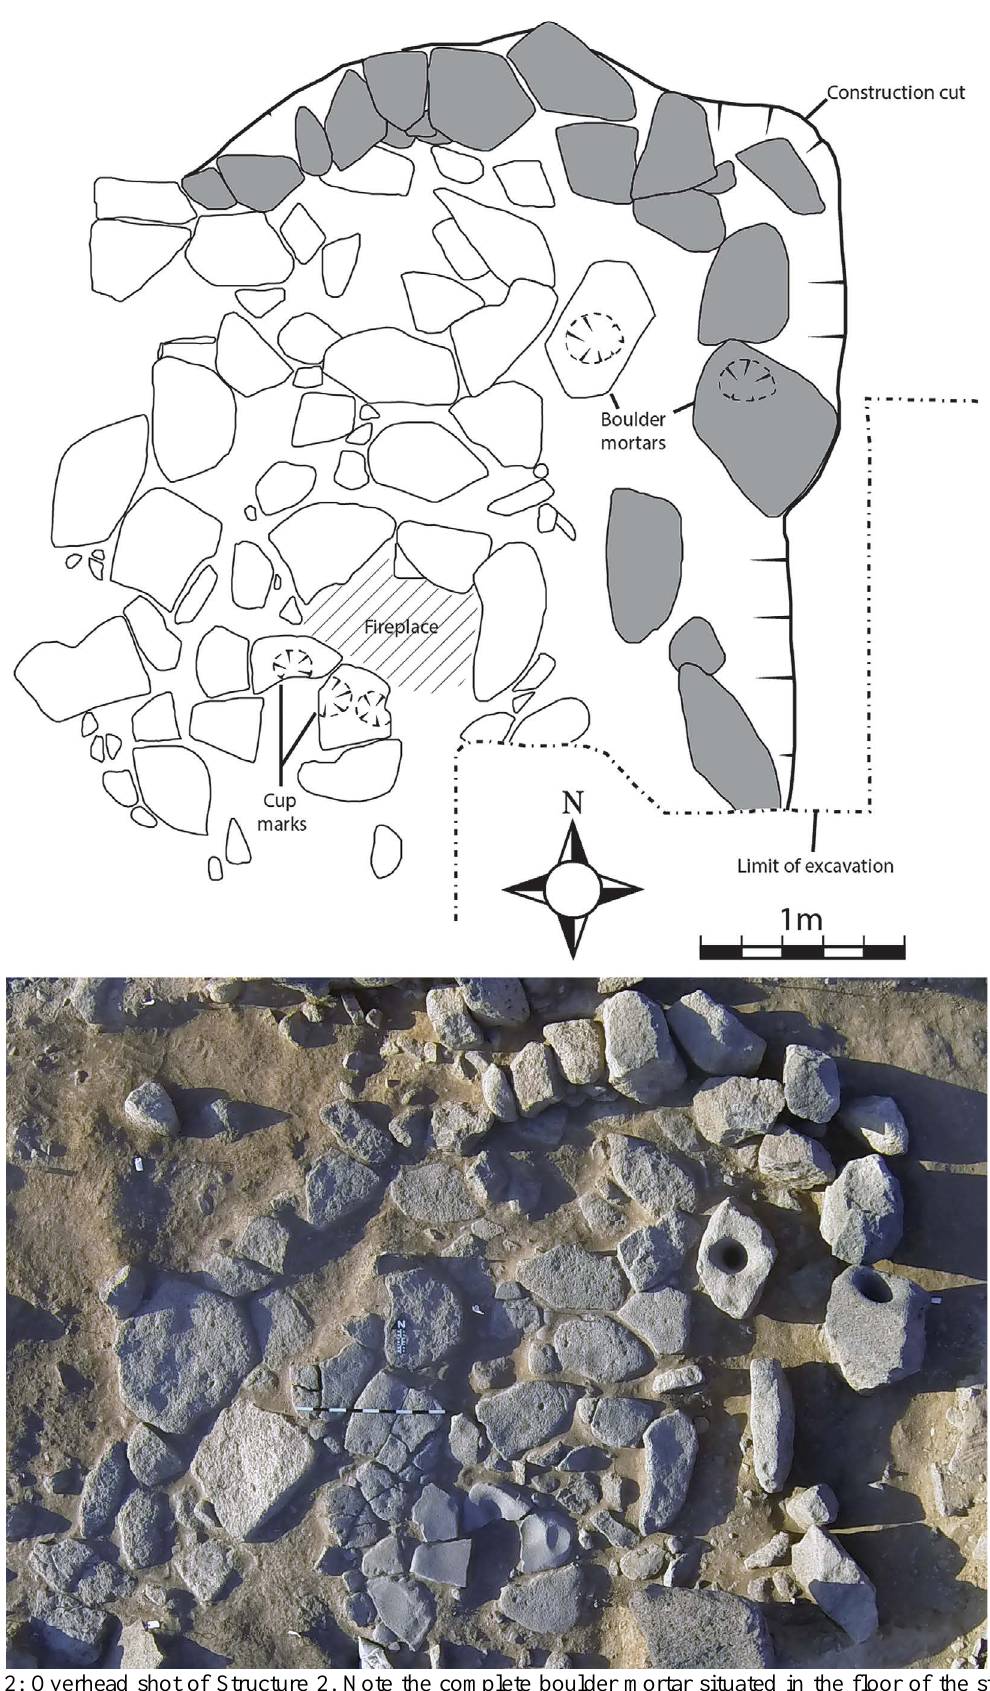
Figure 2: Overhead shot of Structure 2. Note the complete boulder mortar situated in the floor of the structure (see also Figure